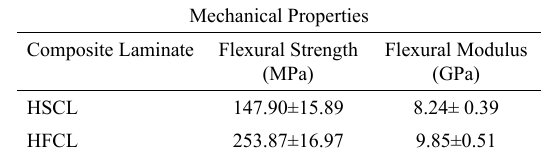
Table 3. Mechanical properties – laminates HSCL and HFCL – three-point